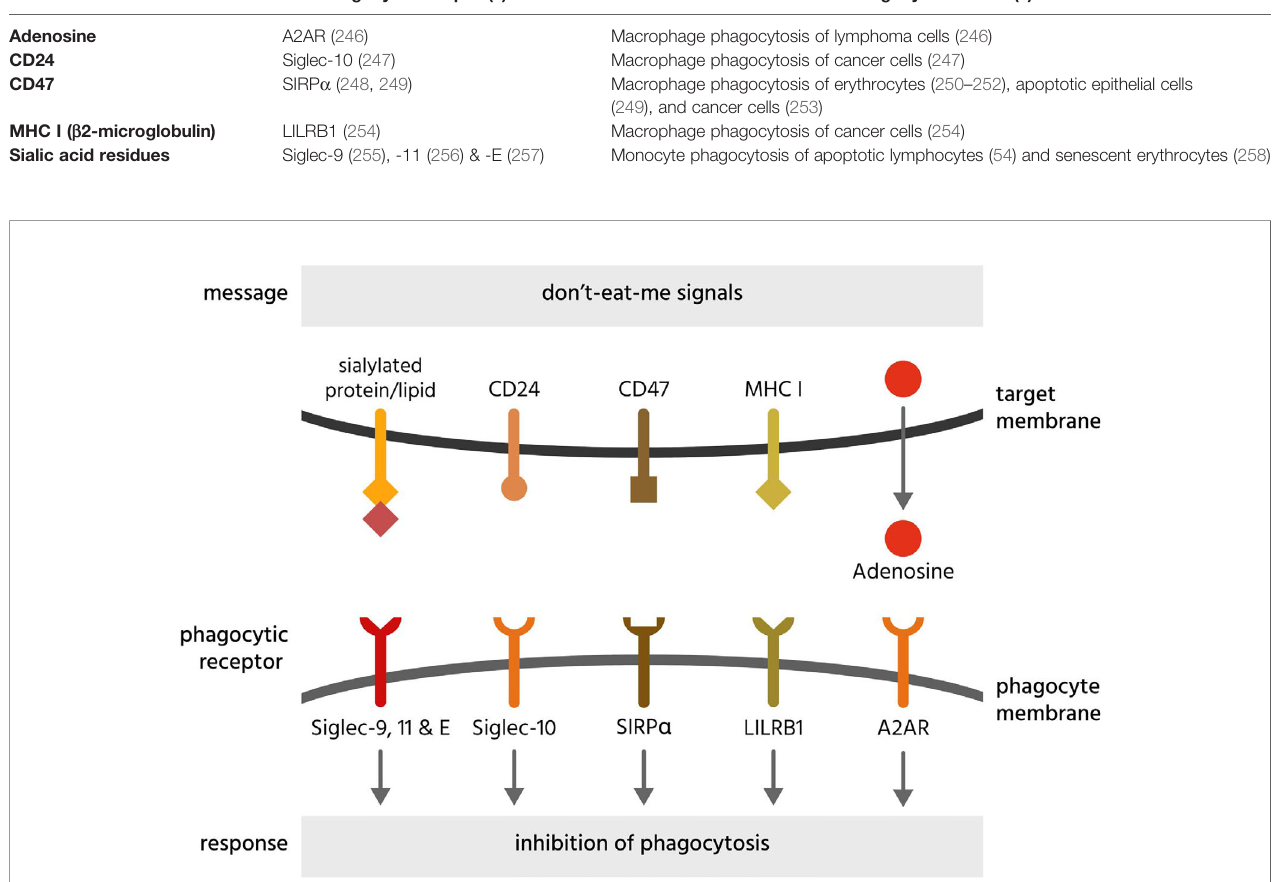
LILRB1, leukocyte immunoglobulin-like receptor subfamily B member 1; MHC I, major histocompatibility complex 1; Siglec, sialic acid-binding immunoglobulin-type lectin; SIRP a , signal regulatory protein a .